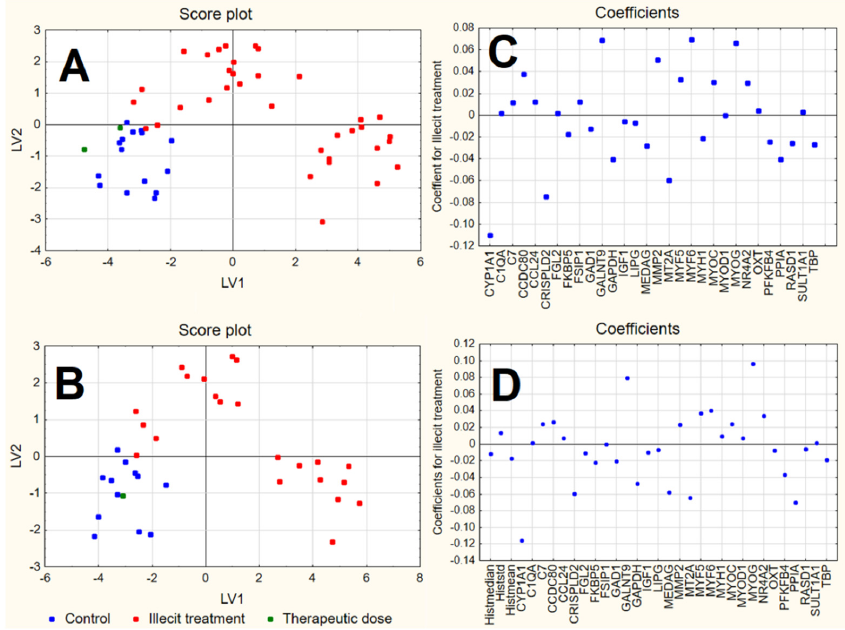
Figure 5. Score plot and plot of the coefficients of the first 2 LVs calculated by PLS-DA on RQ ( A , C ) and RQhisto ( B , D ) datasets